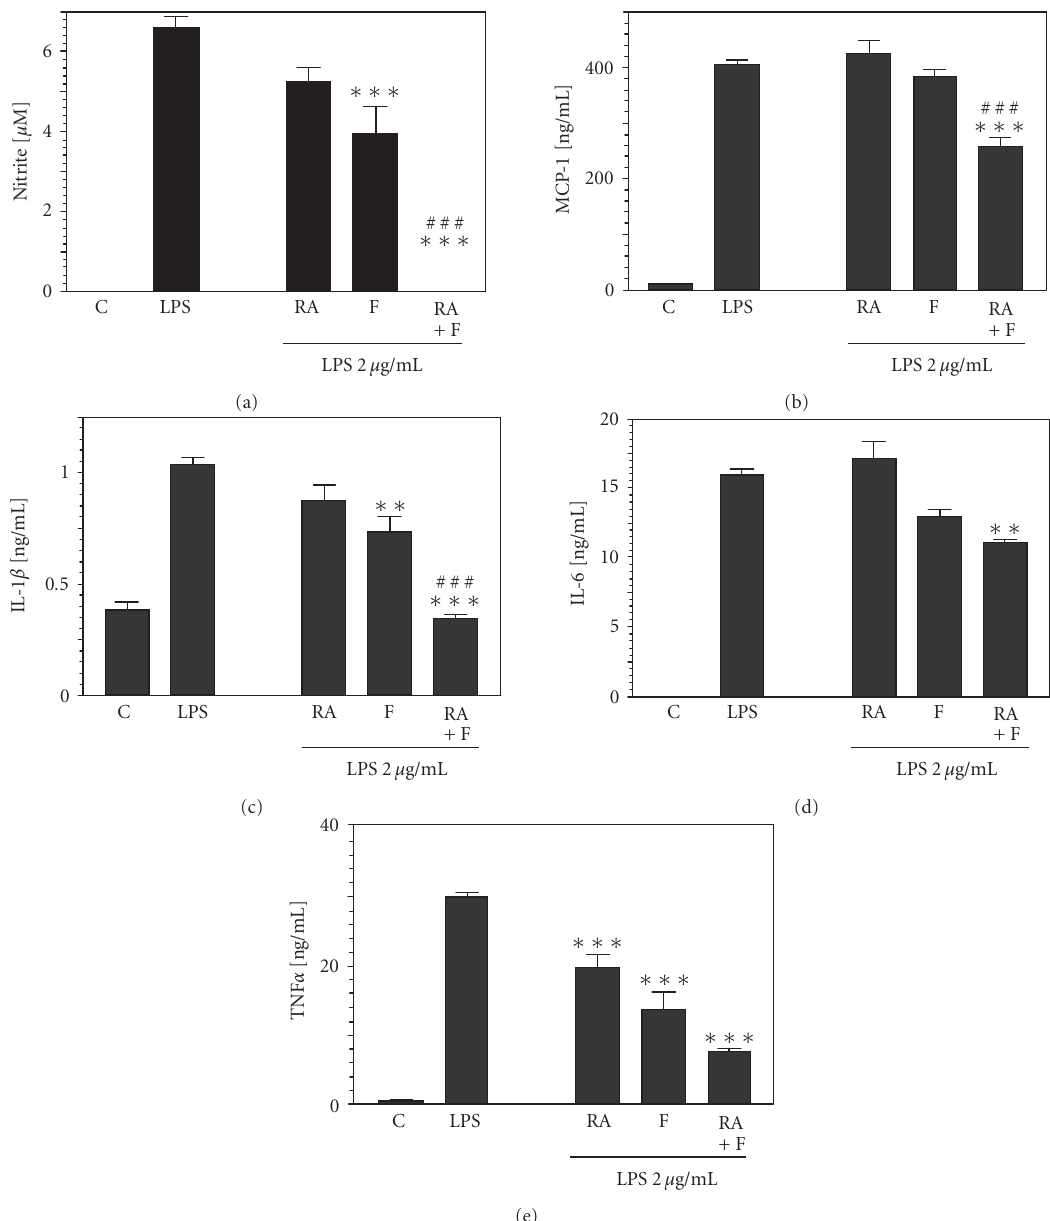
(e) Figure 3: Anti-inflammatory e ff ects of PPAR and RAR agonists in astrocytes. Astrocyte primary cultures from cortices of newborn mice were treated with 9- cis RA (RA) and/or the PPAR α agonist fenofibrate (F) for 1hour and then stimulated with 2 μg/mL LPS for 24 hours. (a) Nitrite production as an indicator of NOS activity was reduced by 1 μM RA or 100 μM F, and completely suppressed with RA plus F. Pretreatment of RA and/or F also decreased the release of (b) the chemokine MCP-1 (RA: 2 μM , F: 200 μM ), and cytokines (c) IL-1 β (RA: 1 μM , F: 100 μM ), (d) IL-6 (RA: 2 μM , F: 50 μM ), and (e) TNF α (RA: 1 μM , F: 100 μM ) in response to LPS. Cytokine production was measured with ELISA. Experiments with microglia cultures revealed similar e ff ects, except for MCP-1, whose production was stimulated by 9-cis RA in microglia. Error bars indicate SEM, asterisks indicate significant di ff erences compared to the LPS condition (sources: [54,